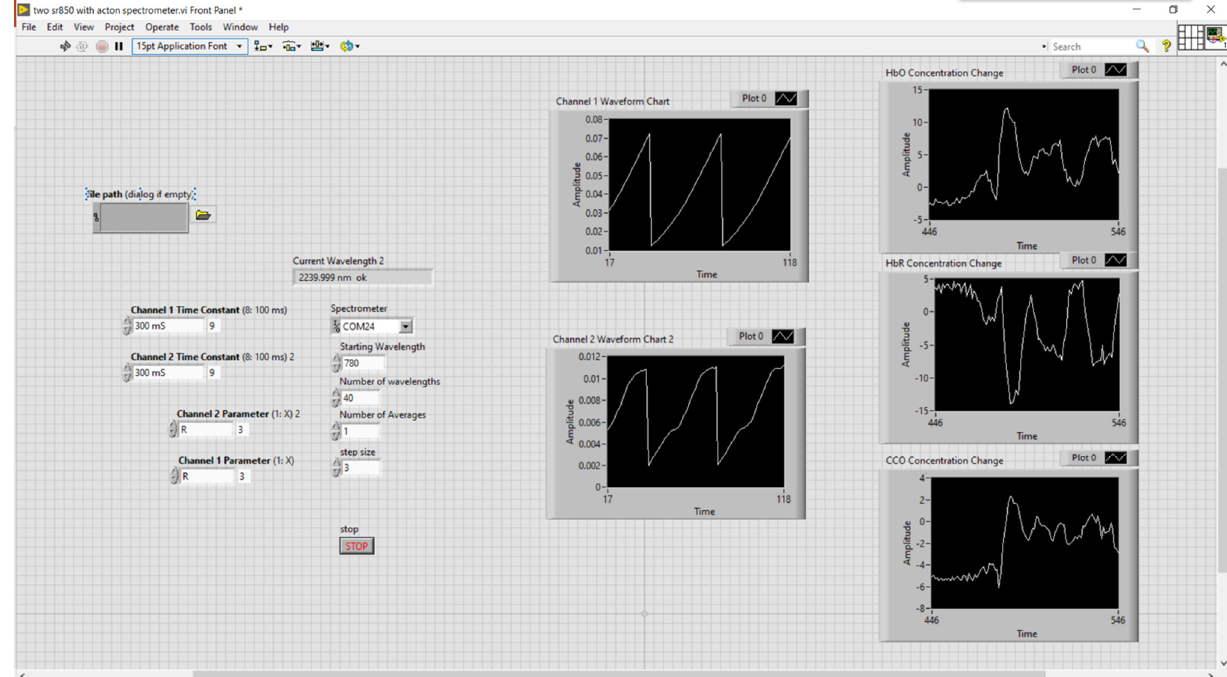
Figure 29. Cart-based SCISCCO prototype software and graphical user interface (GUI).